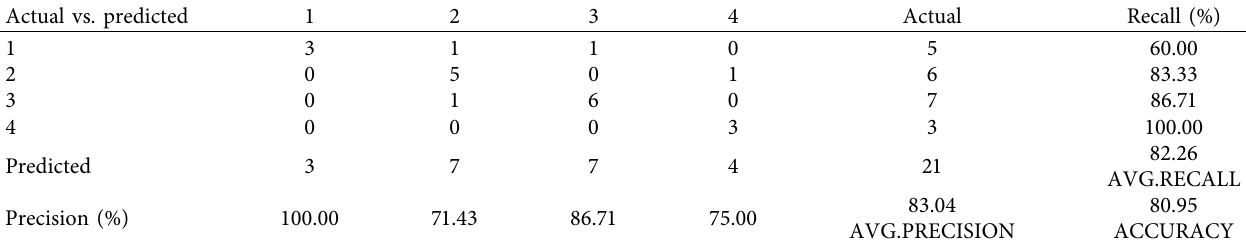
Table 8: Confusion matrix of deep network model test results and model evaluation related indicators. Actual vs.